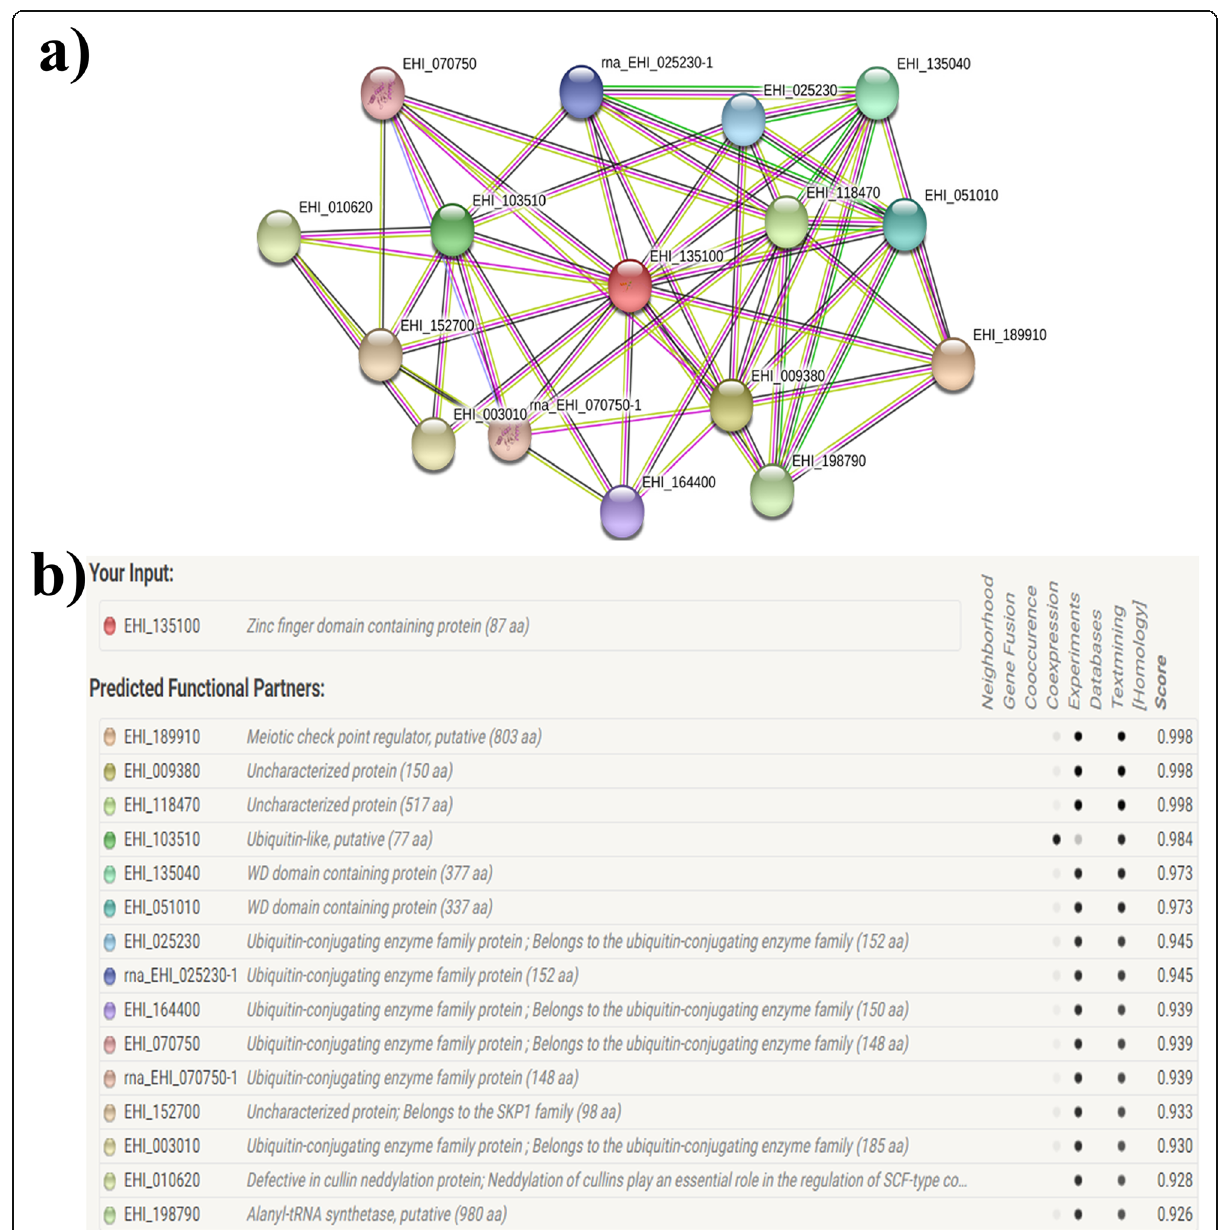
Fig. 5 Protein-protein interactions of EhApc11 by STRING. a Network map of predicted interactions. b Summary of predicted interacting proteins. The network nodes indicate interacting proteins. The position of EhApc11 is labelled as EHI_135100. Seven different coloured lines indicate the seven different categories of evidences used in predicting the associations (green = neighbourhood, red = gene fusion, blue = co-occurrence, black = co-expression, pink = experiments, sky blue = databases, light green = text mining, grey =